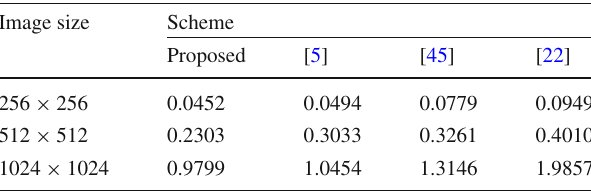
Table 6 Comparison of the encryption time (in seconds) for the pre- sented encryption cryptosystem with the corresponding approaches for greyscale images of various